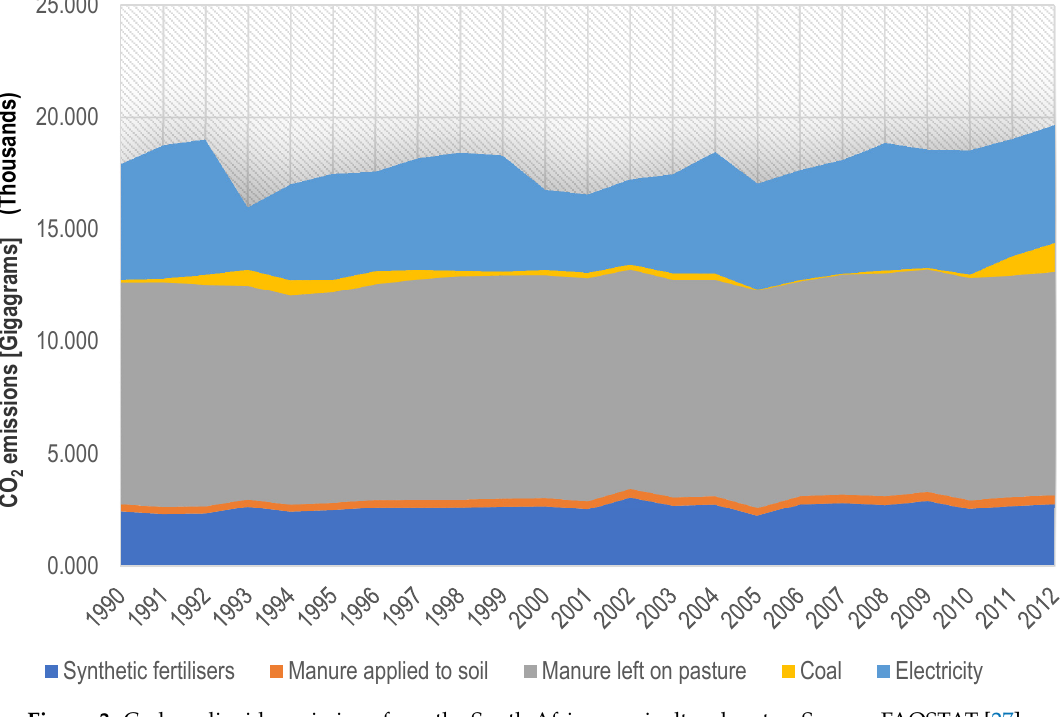
Figure 3. Carbon dioxide emissions from the South African agricultural sector. Source: FAOSTAT [27].